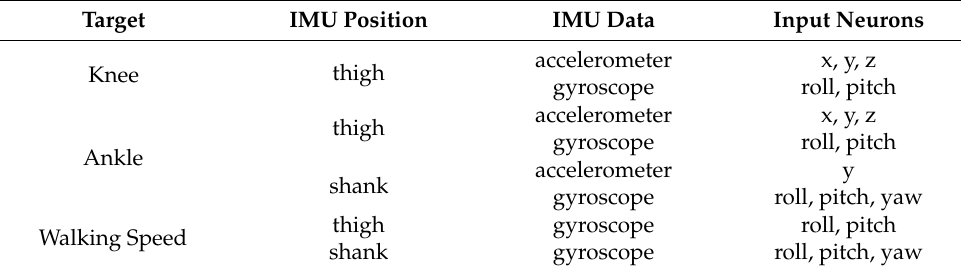
Table 3. Input neurons for estimation of the knee, ankle, and walking speed.